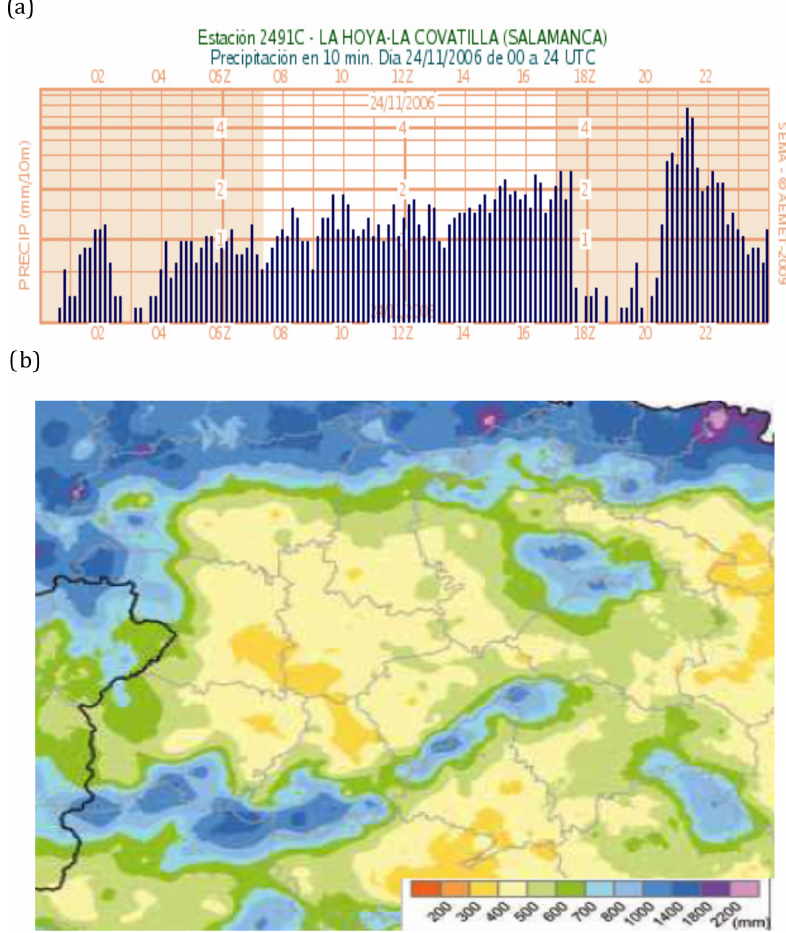
Figure 6. (a) Temporal distribution of precipitation observed at the La Covatilla weather station (see Fig. 1b) on 24 November; (b) spatial pattern of average precipitation observed over the area for the period 1971–2000 including to the north of